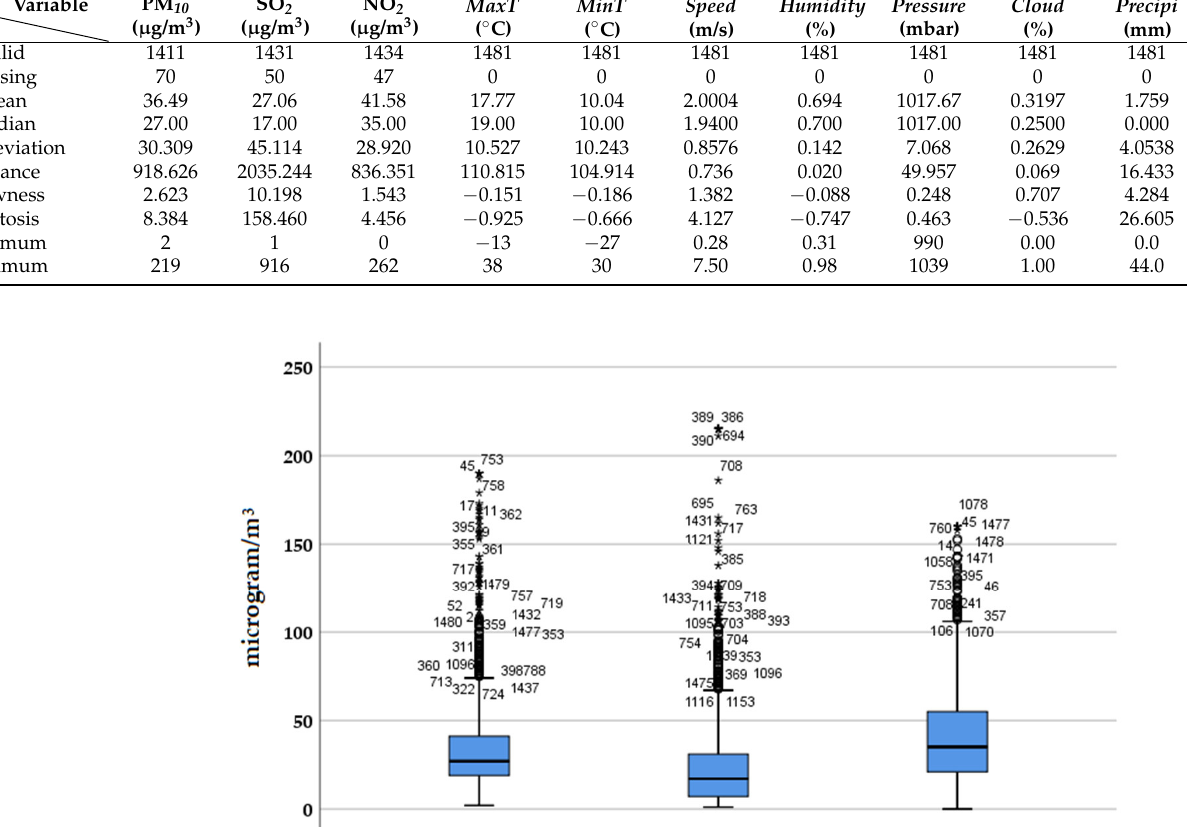
Table 2. Summary statistics of the initial data for pollutants and meteorological variables.